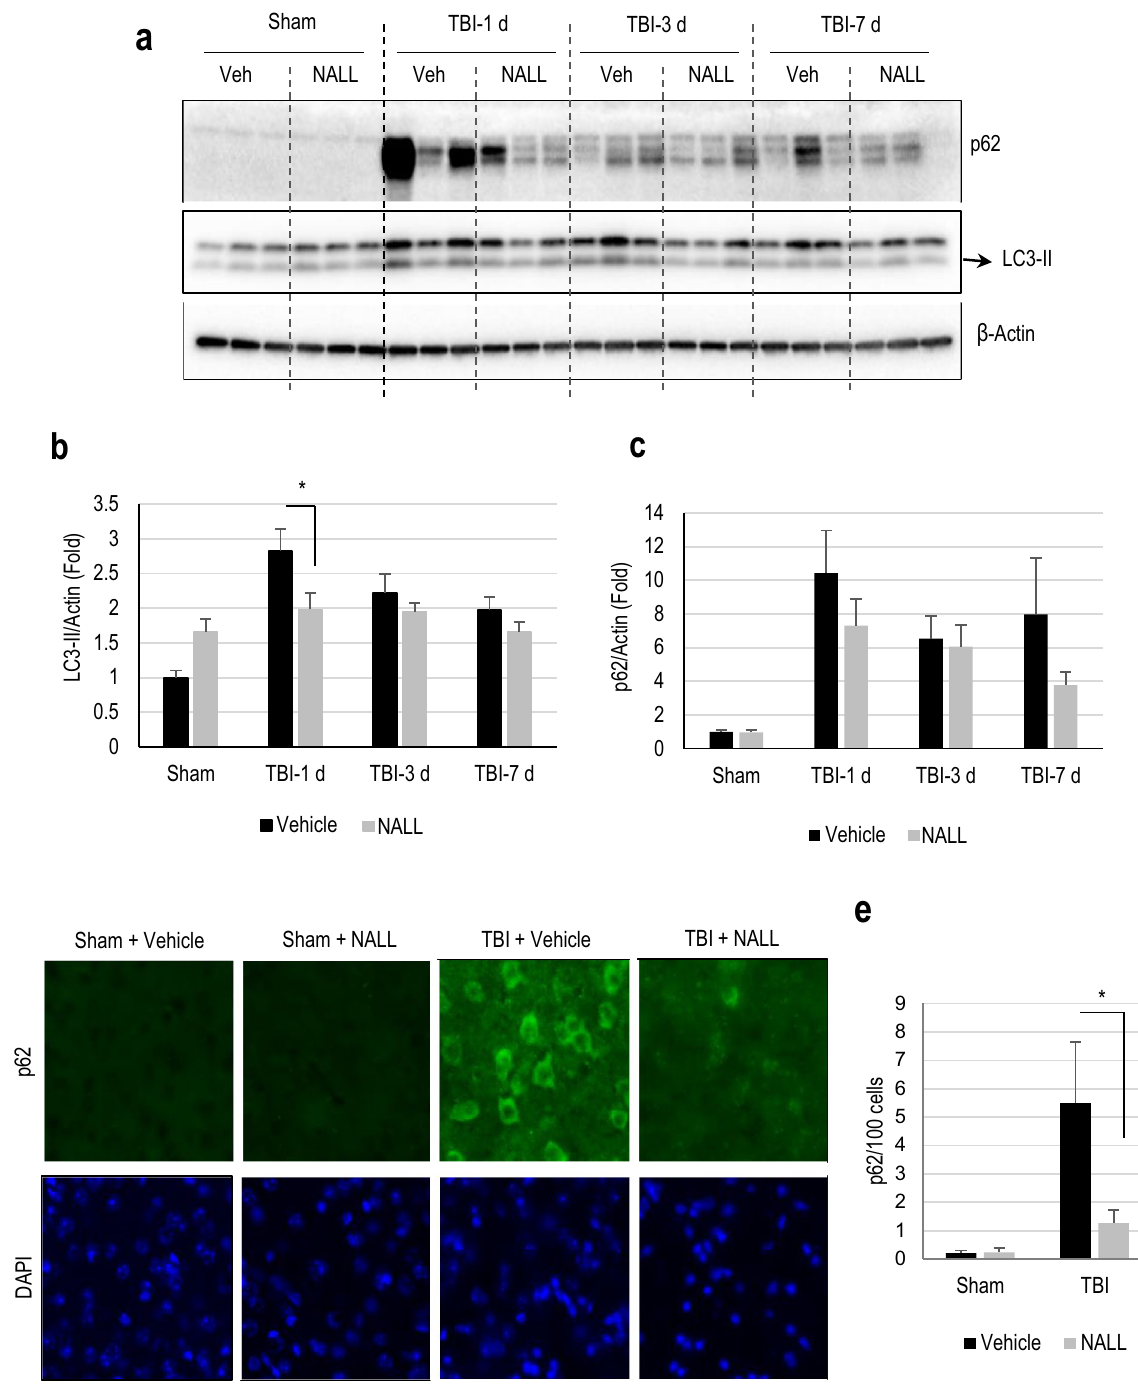
Figure 3. NALL restores autophagy flux after TBI. ( a ) Western blot of cortical tissue lysates from sham and TBI mice fed with NALL or vehicle for autophagosomal marker LC3 and autophagic cargo adaptor proteins p62/SQSTM1 and ( b , c ) corresponding densitometric analysis. Data are presented as mean ± SEM. n = 5 (only 3/group included for representative images for western blot analysis), *p < 0.05 (Two-way ANOVA with Bonferroni posttests). ( d ) IF staining for p62/SQSTM1 on frozen sections prepared from mouse cortical brain sections at 1 day after TBI. ( e ) Quantification of image data from d. Data are presented as mean ± SEM. n = 5/ group, *p < 0.05 (Two-way ANOVA with Sidak